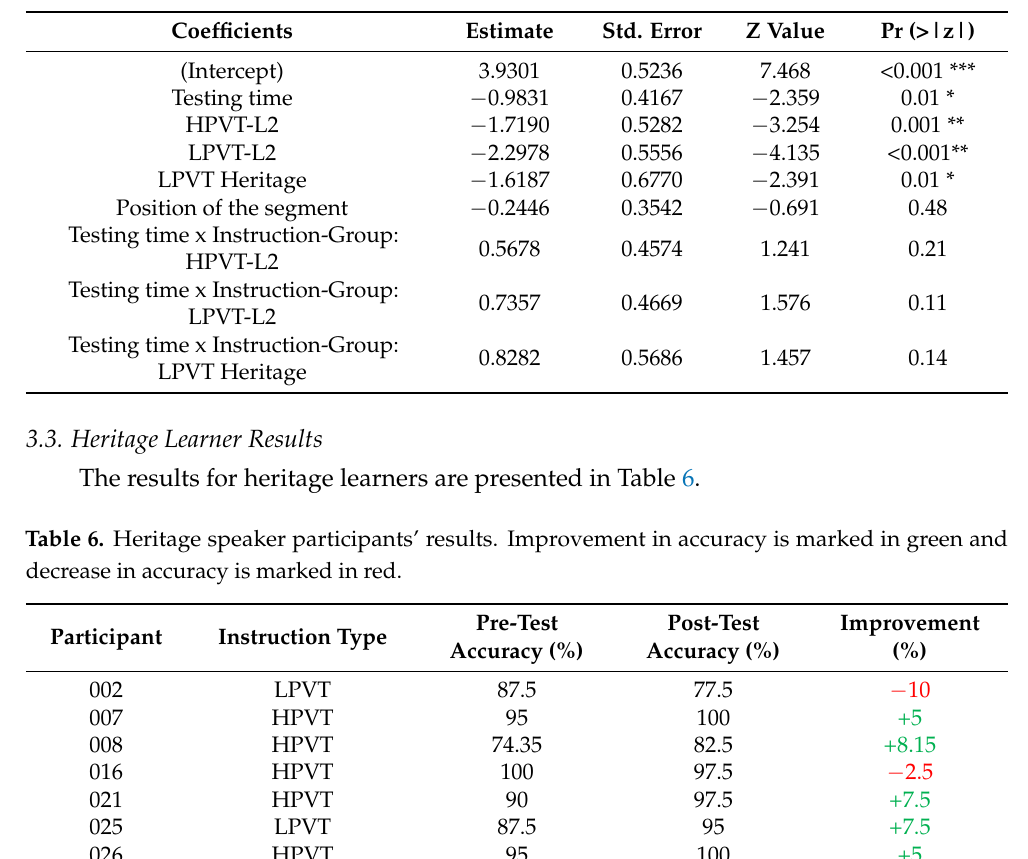
Table 5. Glmer model for type of instruction and group, and testing time.